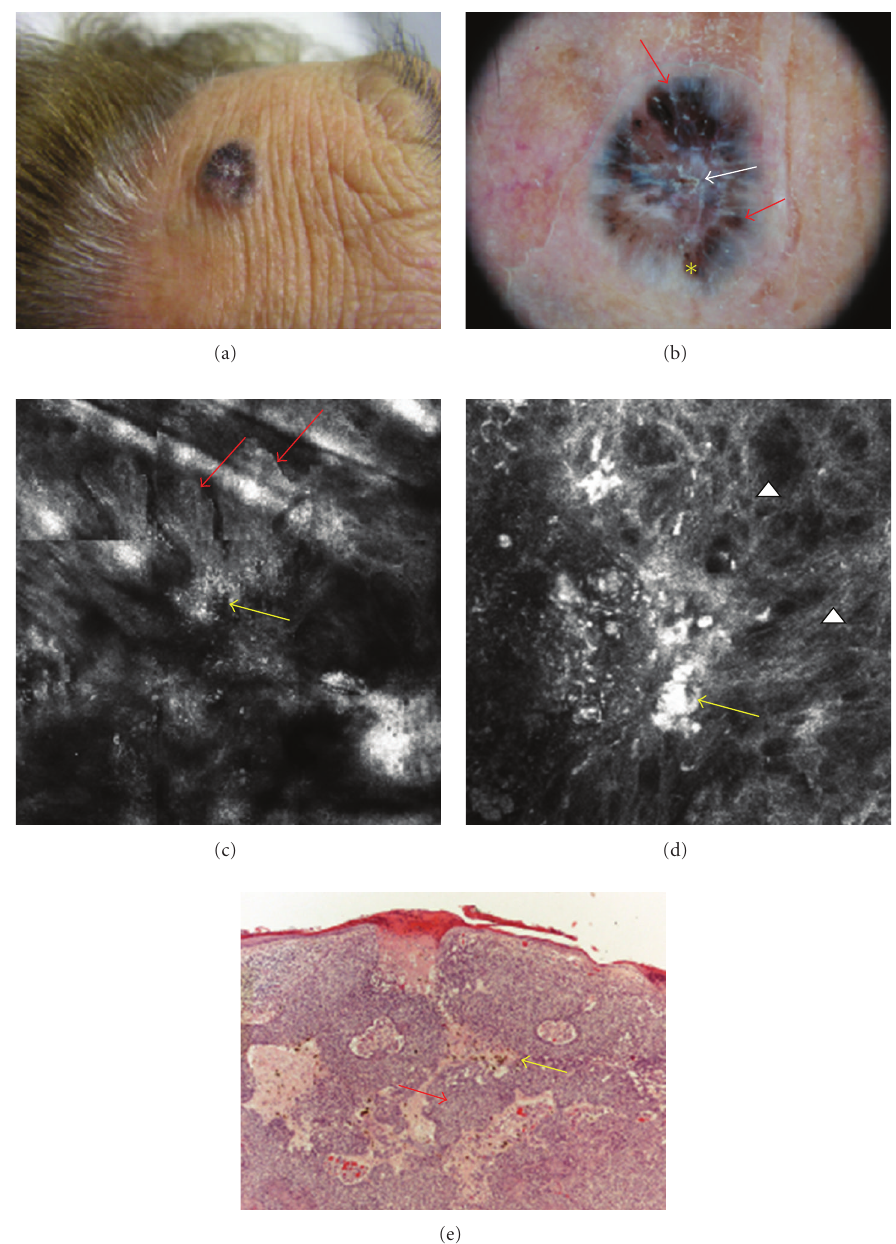
Figure 3: Forehead of a 75-year-old woman. A bluish, ulcerated nodule (a). The dermoscopic images were characterized by the presence of blue-brown leaf-like structures (red arrows), with an area of ulceration in the center, surrounded by white bright lines, with a chrysalis structure aspect (white arrow) and some brownish and black globular-like structures all over the lesion (yellow asterisk) (b). Confocally, reflectant tumor islands with palisading cells at the periphery ((c) red arrows) and bright cells in their inner portion ((c) mosaic 1 . 5 × 1 . 5 mm; (d) detail 500 × 500 µ m; yellow arrow), were present, mixed to thickened collagen fibers ((d) white arrow head). Histopathology confirmed the diagnosis of a BCC with a high correspondence, showing tumor islands ((e) HH 10x magnification, red arrow) and numerous melanophages (yellow